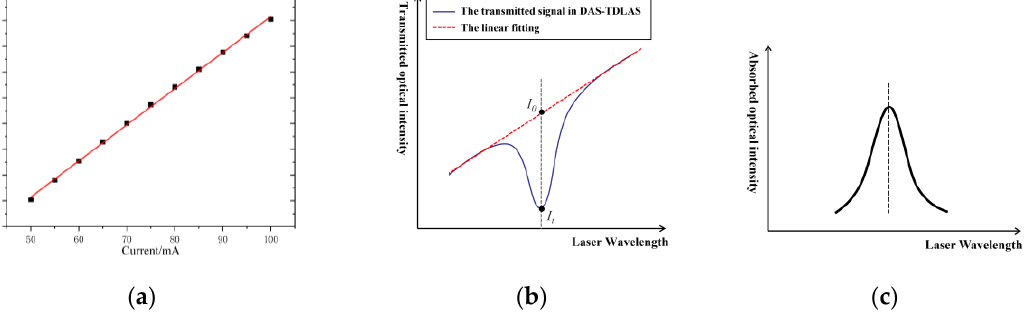
Figure 5. DAS-TDLAS detection: ( a ) the light power of the diode laser varies with driving current; ( b ) the transmitted optical intensity varies with laser wavelength and its linear fitting; ( c ) the absorbed optical intensity varies with laser wavelength.